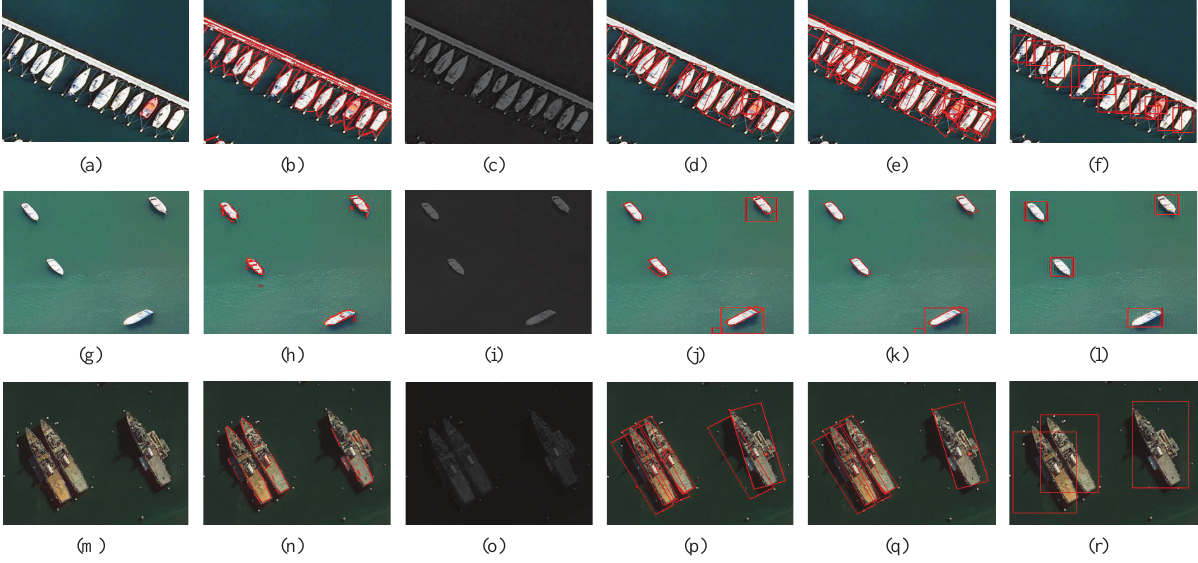
Figure 8: The results of ship detection system process. (a), (g) and (m) are images with inshore ships, offshore ships and warships respectively. (b), (h) and (n) show the line segment results and (c), (i) and (o) are images with results of salient map. In (d), (j) and (p), the ship proposal detection results based on ship model method are showed, and in (e), (k) and (q), ship proposal detection are labeled with salient map. (a), (g) and (m) are ship detection final results.